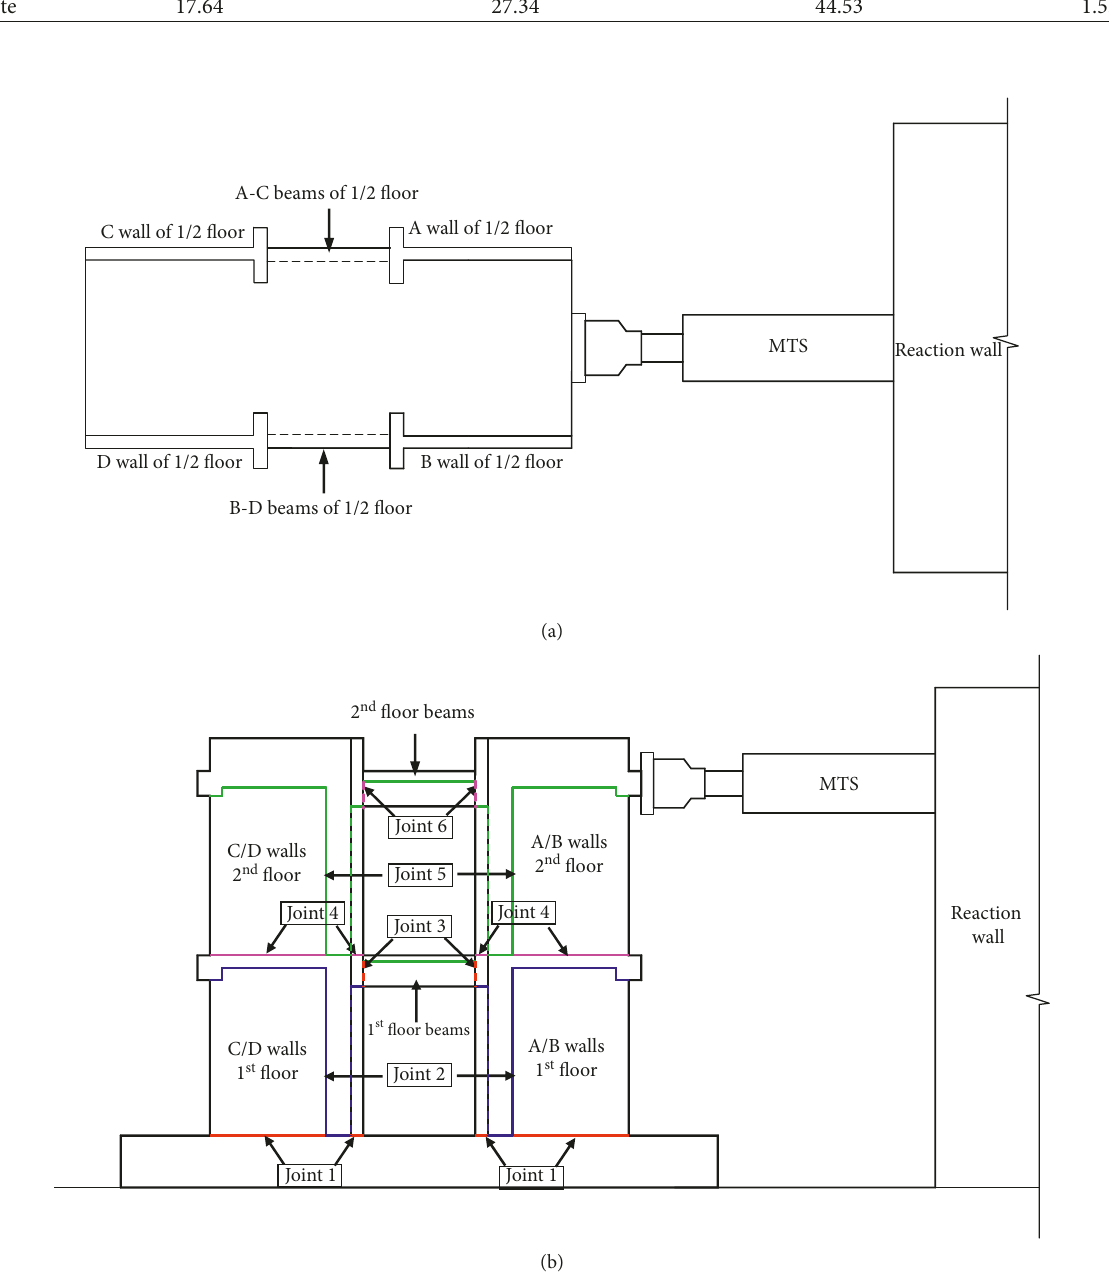
Figure 18: Components and joint interfaces names. (a) Plan view. (b) Elevation view. Note: Joint 1 (red) contains eight joints belonging to the flange and web area joints of A/B/C/D walls at the 1st floor. Joint 2 (blue) contains the initial and postconcrete pouring joints of shear walls at the 1st floor. Joint 3 (red) contains the beams-postconcrete pouring shear wall joints at the 1st floor. Joint 4 (purple) contains eight parts belonging to the flange and web area joints of A/B/C/D walls at the 2nd floor. Joint 5 (green) contains the initial and postconcrete pouring joints of shear walls at the 2nd floor. Joint 6 is the beams-postconcrete pouring shear wall joints at the 2nd floor.